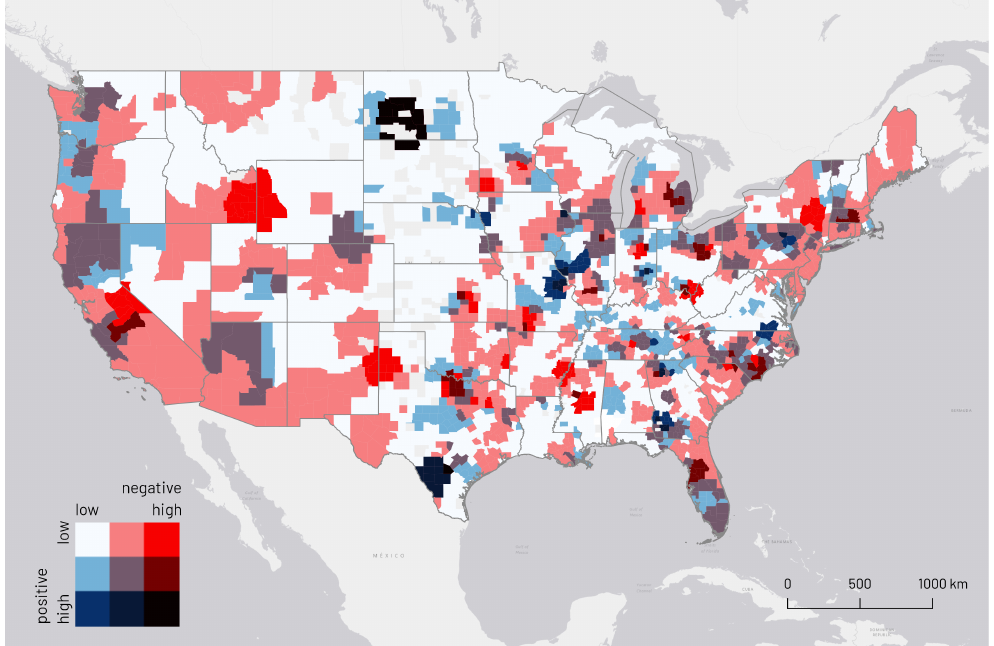
Figure 4. Bivariate map of negative and positive hot spots before the Twitter acquisition (1–26 October 2022). Counties without Tweets are transparent.